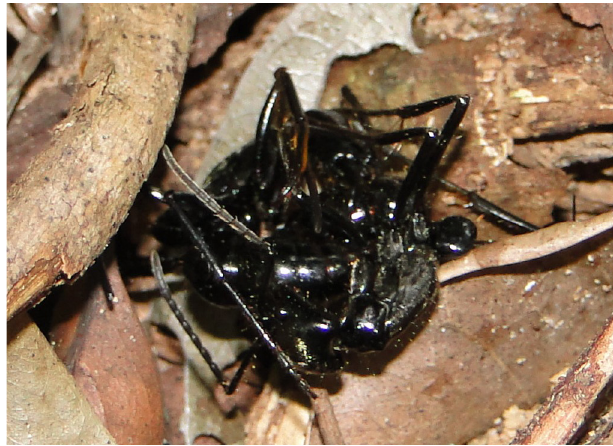
Fig 3 . Agonistic interaction between two Dinoponera lucida workers from different nests at the Reserva Natural Vale, state of Espírito Santo,